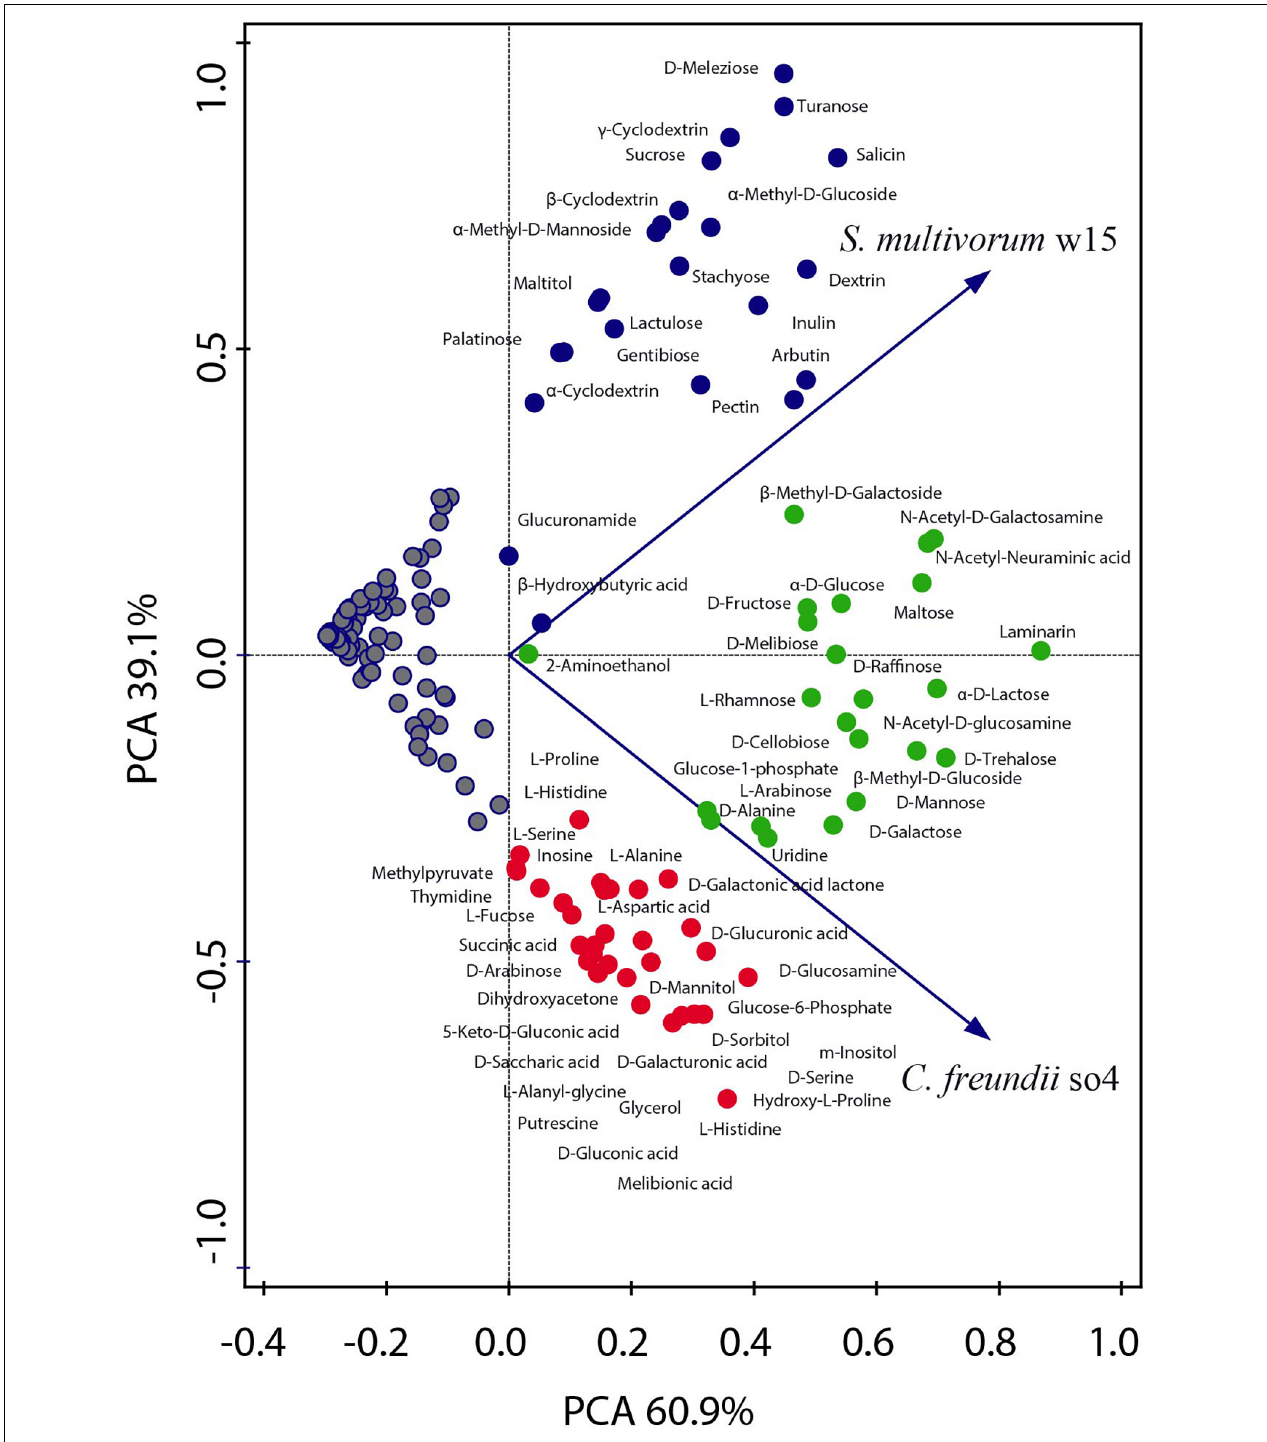
FIGURE 1 | Principal component analysis showing the metabolic capacity of the strains C. freundii so4 and S. multivorum w15. The ability to consume each of the individual carbon sources was tested using BIOLOG PM2A and GN2 plates. C. freundii so4 exhibited the capacity to grow on 52 compounds, mainly intermediate metabolites, amino acids, organic acids, sugar alcohols and monosaccharides (red and green). S. multivorum w15 grew on 42 compounds (blue and green), presenting preference for disaccharides, oligosaccharides and polymers. Red symbols indicate the compounds consumed only by C. freundii so4; blue symbols those consumed only by S. multivorum w15 and green symbols those consumed by both